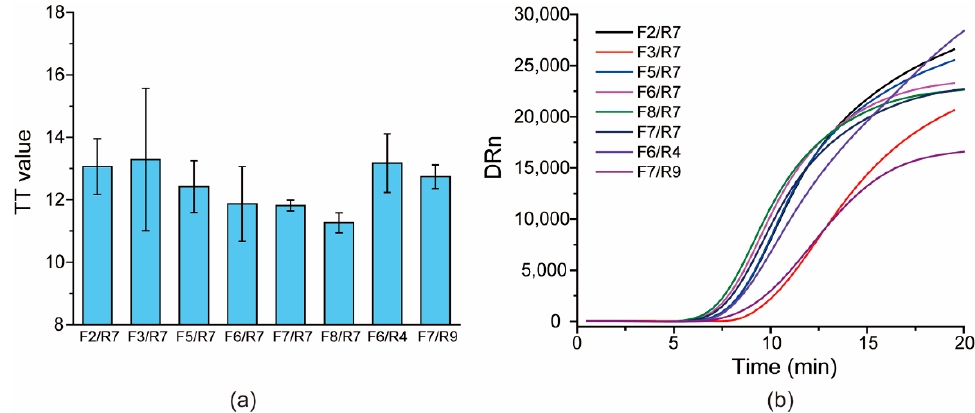
Figure 3. Screening primers: ( a ) the histogram of TT values versus different primer pairs; ( b ) the typical amplification curves for each primer pair.